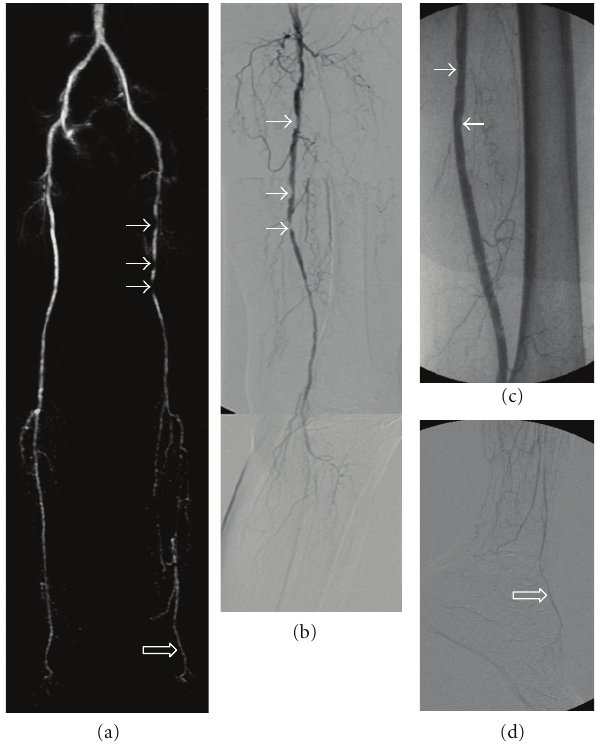
Figure 3: A 72-year-old male with bilateral lower leg ischemic rest pain and left foot ulcers. (a) Concatenated three-station T- MRA demonstrating multiple stenoses (arrows) (type B lesion based on TASC classification) in the left superficial femoral artery and multiple long segmental severe stenoses and occlusions of the infrapopliteal arteries. The left dorsalis pedis artery (open arrow) is patent. (b) Corresponding concatenated DSA demonstrating multi- ple stenoses in the left superficial femoral artery. The infrapopliteal and pedal arteries beyond the left knee are not opacified. (c) Follow- up angiogram after angioplasty of the left superficial femoral artery showing residual mild stenoses (arrows). (d) Selective DSA of the left foot after angioplasty with improved arterial inflow confirming the patency of the dorsal pedis artery (open arrow); the patient was subsequently managed with popliteal-dorsalis pedis bypass